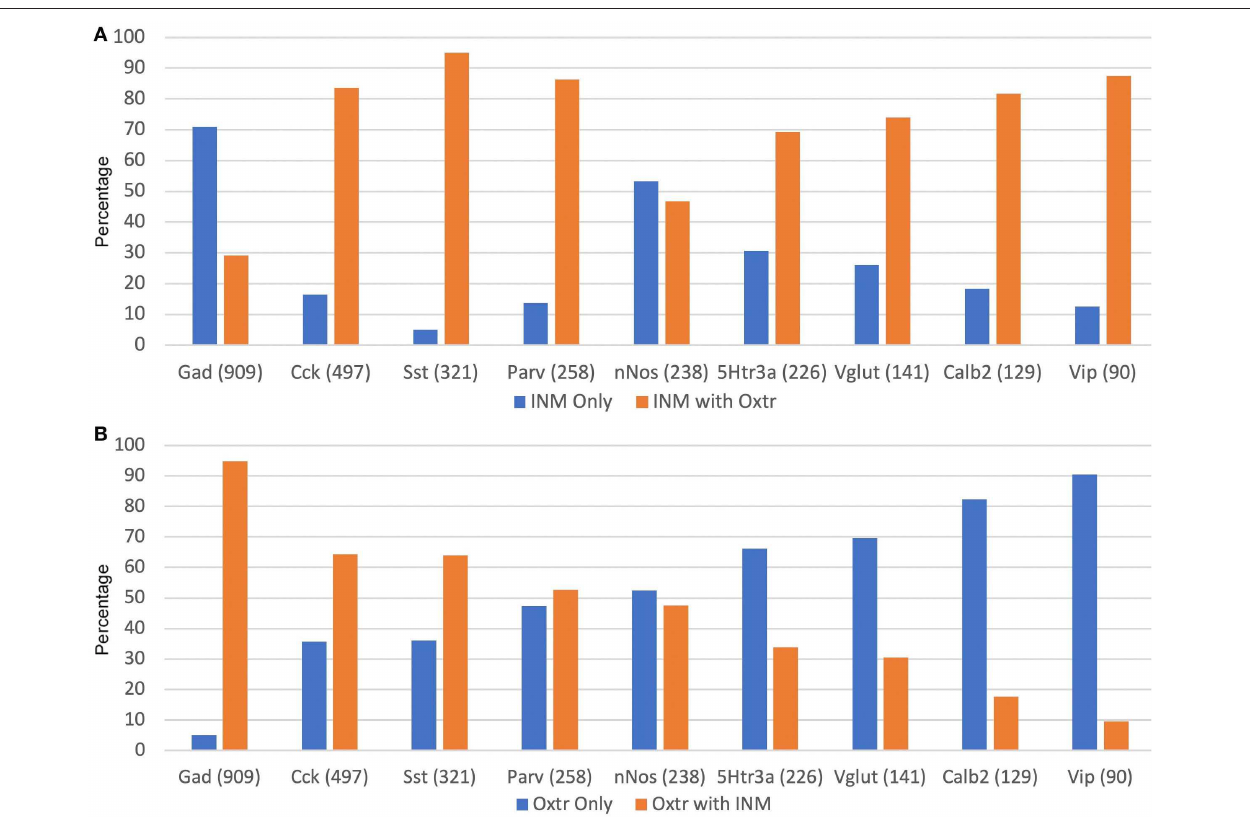
FIGURE 12 | Percentages of INM-expressing neurons containing Oxtr (A) or Oxtr-expressing neurons containing an interneuron marker (B) . The total numbers of each type of INM-expressing neuron are indicated within parentheses. Three thousand seven hundred total Oxtr interneurons were